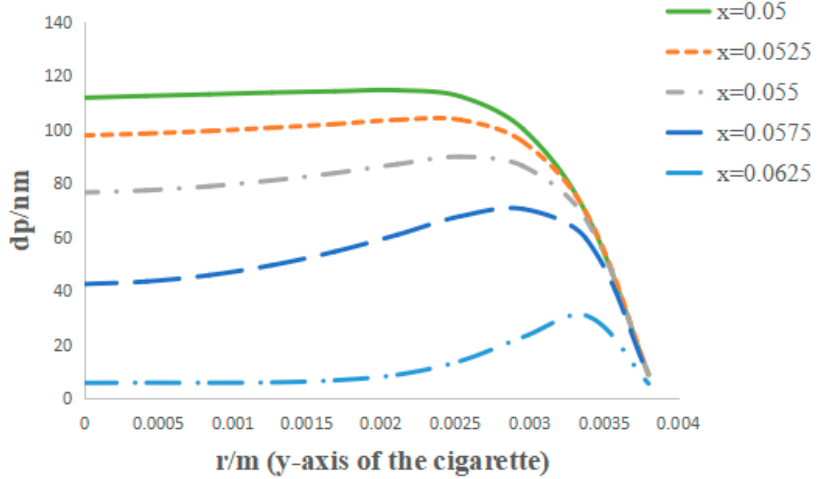
Figure 5. Radial distribution of particle diameters of different cross-sections within the cigarette at 150 s.